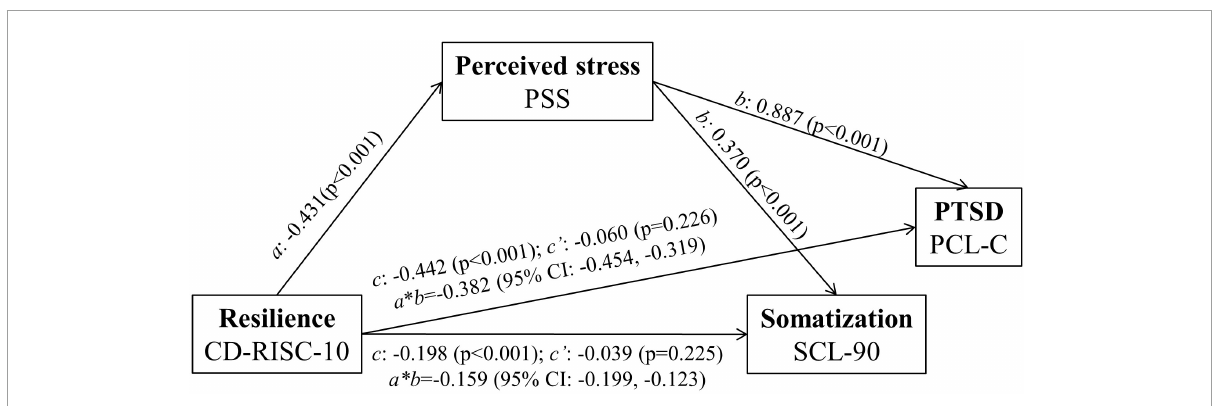
FIGURE2 Mediation analysis exploring the relationship among resilience, PTSD, and somatization. c’, direct effect; c, total effect; (a*b), indirect effect. After monitoring the effects of covariates (age, sex, educational qualification, income, marital status, staff, title, years of work, worksite, work content, provision of support to Hubei in 2019, work schedule/week, ways of COVID-19-related work, training, competence in position, mental support, frequency of contact with family and friends, and psychological support from family and friends), the analysis of mediation models showed that the total effect of resilience on PTSD and somatization remained significant (PTSD: c = -0.433, p < 0.001; somatization: c = -0.170, p < 0.001). The direct effect (c’) of resilience associated with the mediator (PTSD: c’ = -0.086; somatization: c’ = -0.030) was altered but remained insignificant after controlling the variance. These results suggest that perceived stress mainly mediates the association between PTSD and somatization through